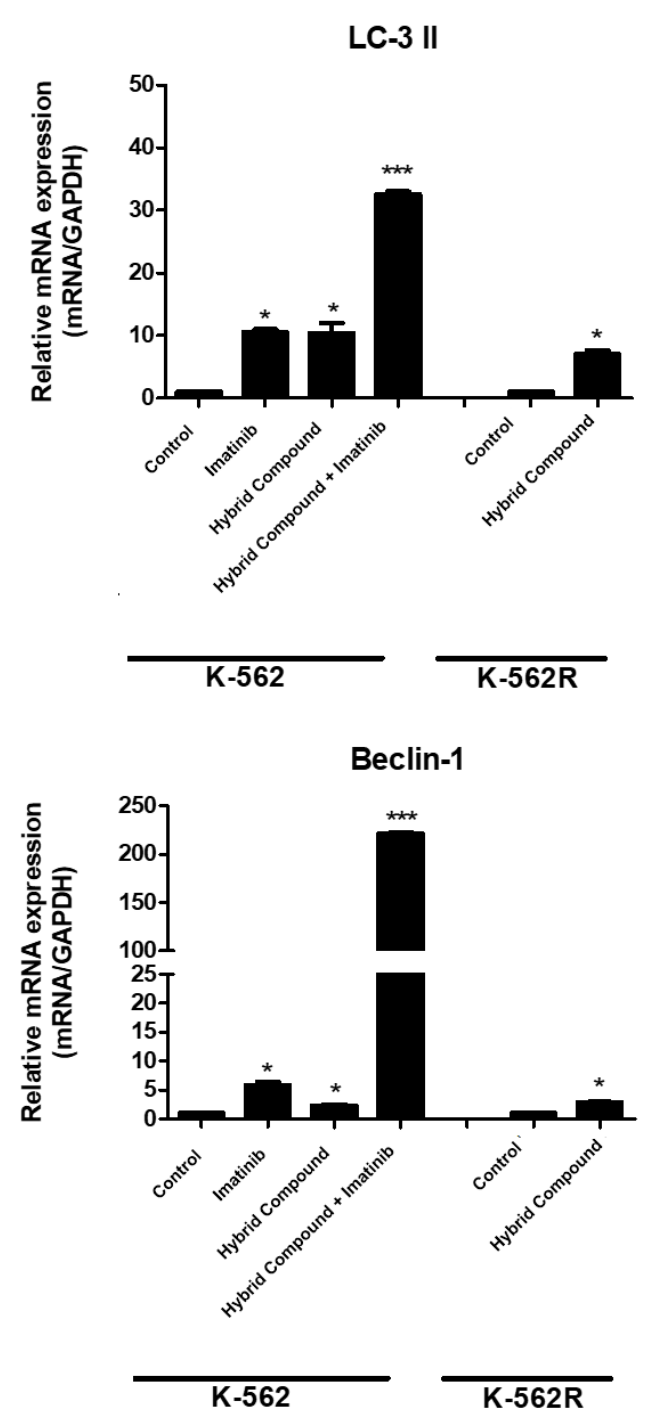
Figure 8. The mRNA expression levels of LC3-II and Beclin-1 were evaluated by qRT-PCR in K-562 cell line treated with imatinib, hybrid compound and the combination of them, and in K-562R cells after treatment with the hybrid compound. Treatments were performed with respective IC 50 for 48 h. Comparative analysis was performed with the 2 − ∆∆ CT method using glyceraldehyde-3-phosphate dehydrogenase (GAPDH) as the endogenous control. The expression ratios were compared to the control. The values are representative of three different experiments. Data were compared by ANOVA followed by Tukey’s test Data are reported as mean ± standard deviation (SD) of three experiments (* p < 0.05; *** p < 0.001 relative to untreated control cells).